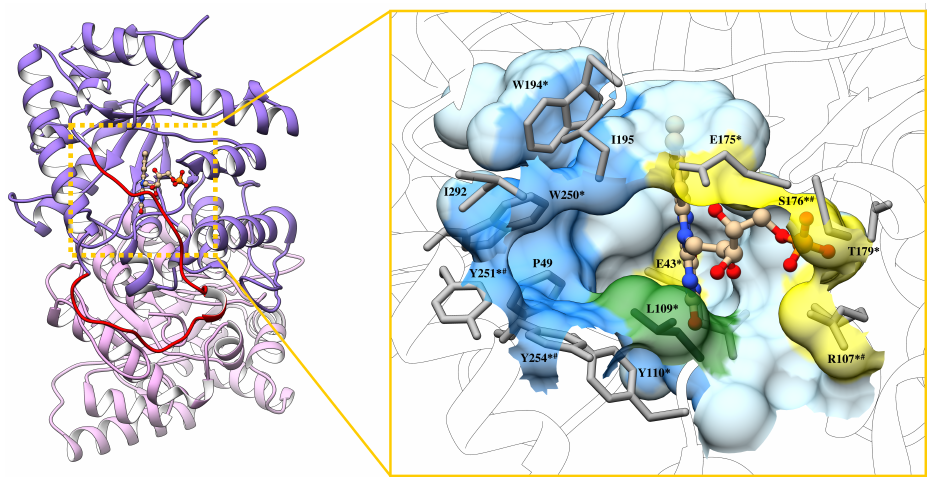
Figure 9. The crystal structure of V. harveyi luciferase (PDB ID: 3FGC) in complex with FMN (CPK representation) in the active site. The mobile loop segment is indicated in red, α and β –subunits—in purple and pink, correspondingly. The surface of luciferase active site cavity was determined by CASTp [31]. Yellow area—amino acid residues that stabilize FMN; blue—the hydrophobic cavity for aldehyde [29,41]. The α Leu109 is involved in the binding of both substrates (green). The superscripts indicate the presence of hydrogen bonds with glycerol (*) and with sucrose ( # ) during MD simulation time (Figures S8 and S9). No superscript means that the H-bonds were not